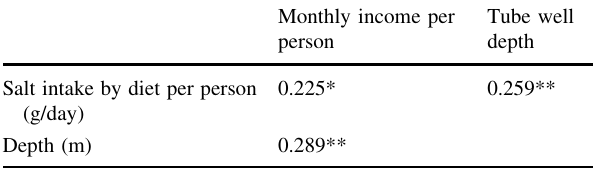
Table 4 Correlations between salinity level, tube well depth, and income in the study area in Chakaria Upazila, Bangladesh,